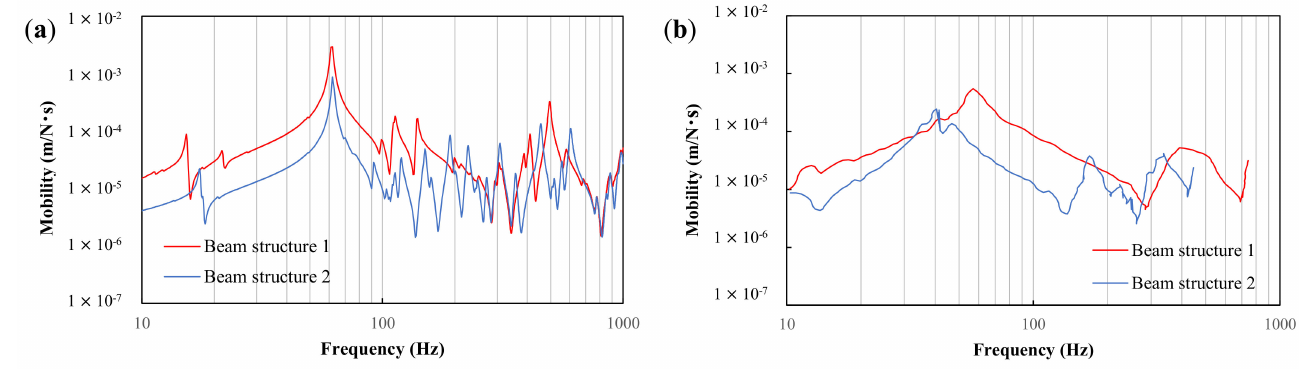
Figure 11. ( a ) FEM results obtained in present study; ( b ) measurement results from Sho et al.